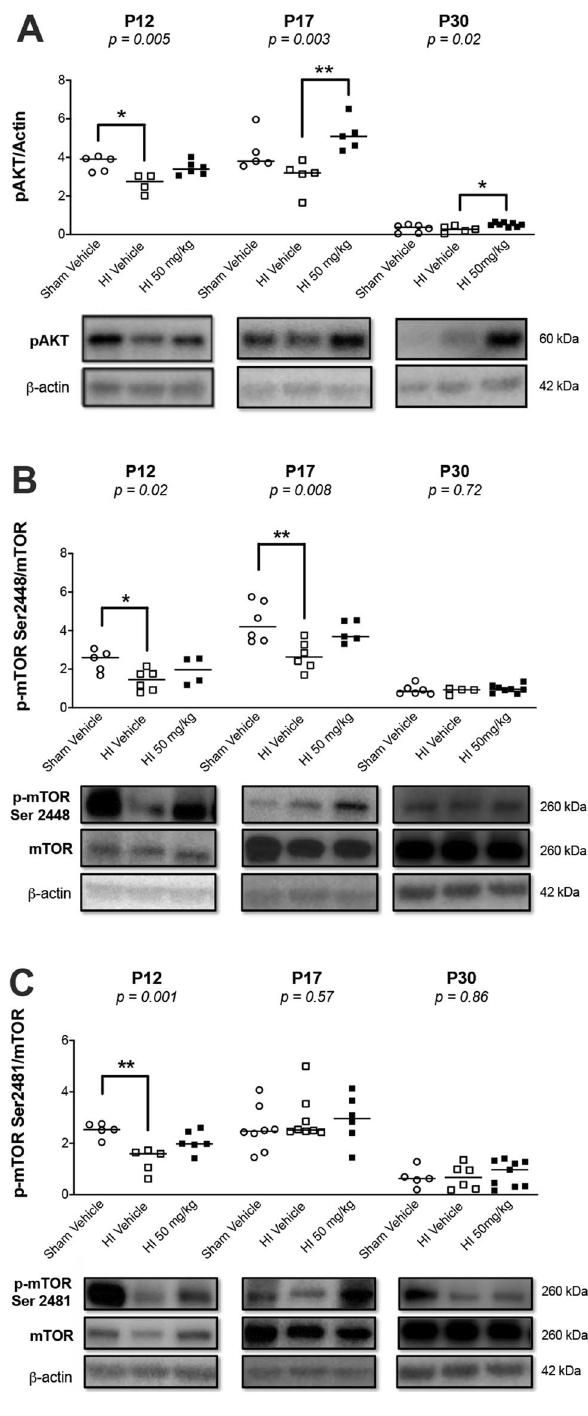
Figure 6. Western blotting for markers of the Pl3k/AKT/MTOR pathway of the ipsilateral hippocampus in sham and HI rat pups treated with vehicle or sildenafil. Median with individual data points representation, with cropped representative western blots. Full-length blots are presented in Supplementary Material. ( A ) p-AKT, ( B ) p-MTOR ser 2448 (mTORC1), and ( C ) p-MTOR ser 2481 (mTORC2). Significance: p value from Kruskal– Wallis test, with Dunn’s post-hoc comparison tests * p < 0.05, ** p < 0.01. Number of animals: n = 6/8/7 sham vehicle, 6/8/7 HI vehicle, and 7/8/10 HI 50 mg/kg, respectively at